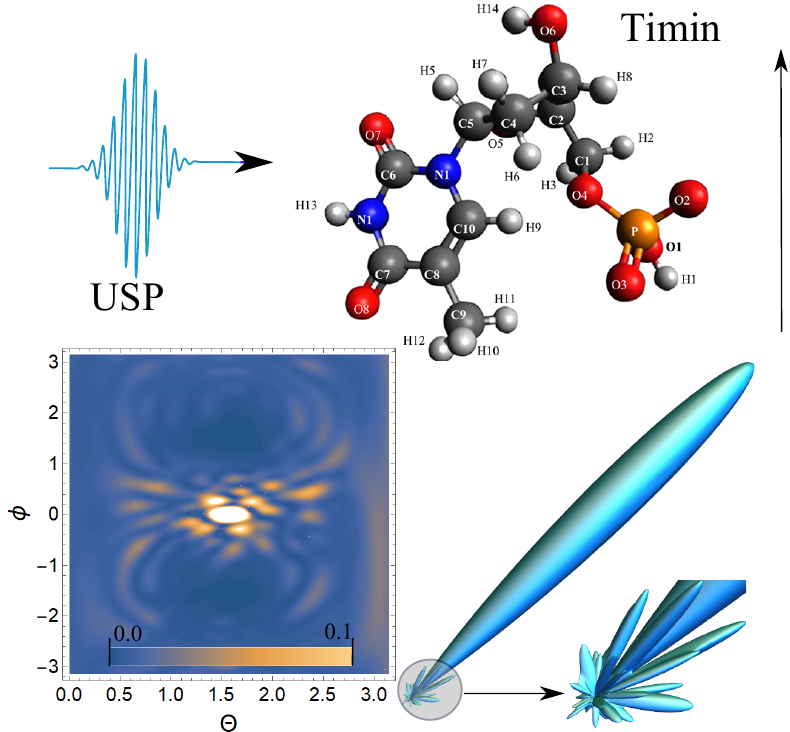
Figure 4. The spectra of USP scattering on thymine are represented. The rest is similar to Figure